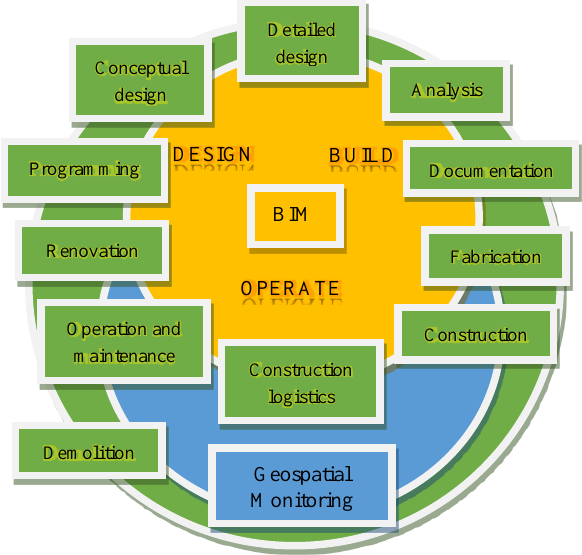
Figure 2 . A liaison of Building Lifecycle, BIM, and Geospatial